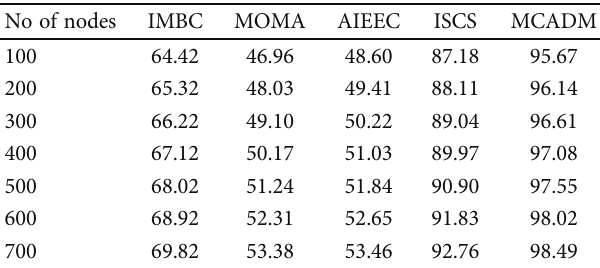
Table 5: Management of intensive operating cycle.